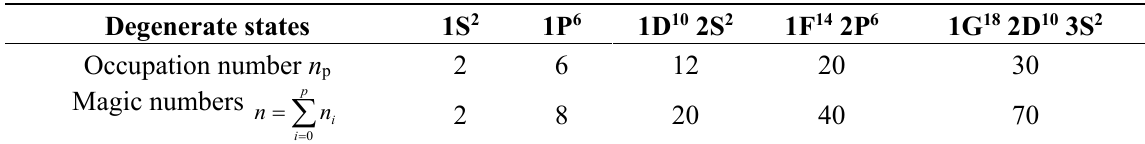
Table 1. Magic numbers, N , obtained following the rule of increasing energy (Aufbau rule), correspond to the shell closures and the ordering of degenerate states obtained with the 3D harmonic potential for metal